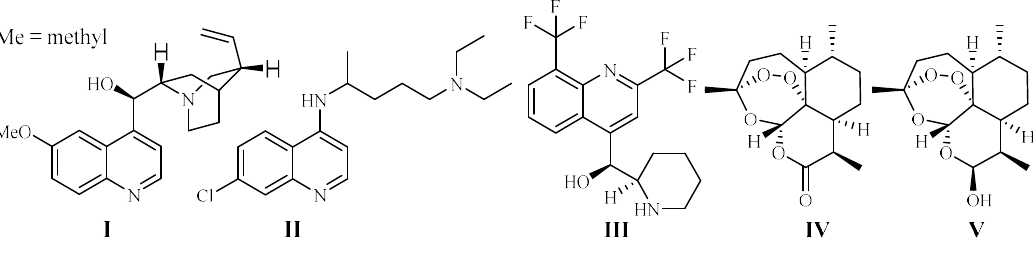
Figure 1. Antimalarial drugs developed from plants.